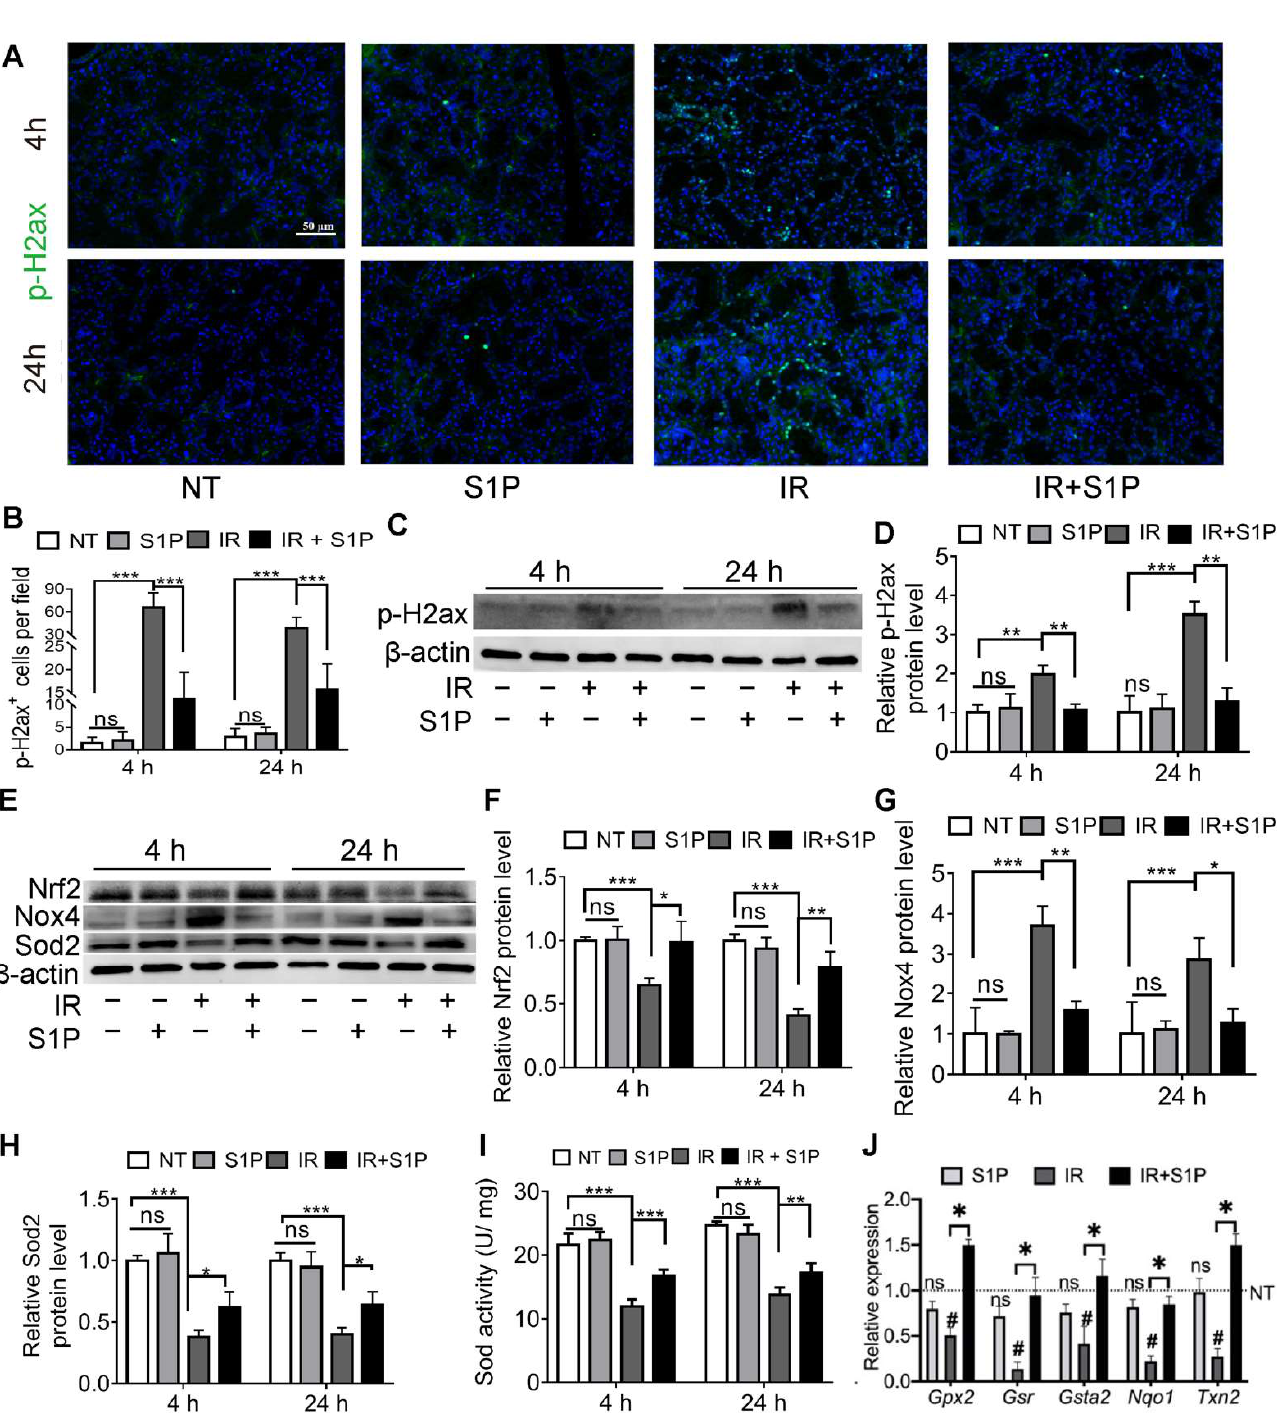
Figure 3. S1P decreased oxidative stress and DNA damage in radiated salivary glands. ( A – D ) Levels of p-H2ax in SMGs collected at 4 or 24 h after IR were examined with immunofluorescence staining and Western blot analyses. Magnification: × 400. ( E – H ) Levels of Sod2, Nox4 and Nrf2 proteins in SMGs were examined with Western blot. ( I ) Sod activities in SMG homogenate were examined with a commercial kit. ( J ) mRNA levels of Nrf2 target genes in SMGs collected at 24 h after IR were examined with RT-qPCR. Data are shown as mean ± SD, N = 3, ns: not significant vs. NT, #: p < 0.05 vs. NT, *: p < 0.05, **: p < 0.01, ***: p < 0.001. Quantitative data were analyzed using one-way ANOVA with Tukey’s multiple comparisons.